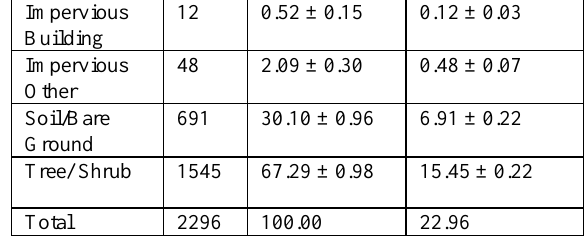
Table 1 . Land cover classes of Uncalı cemetery.